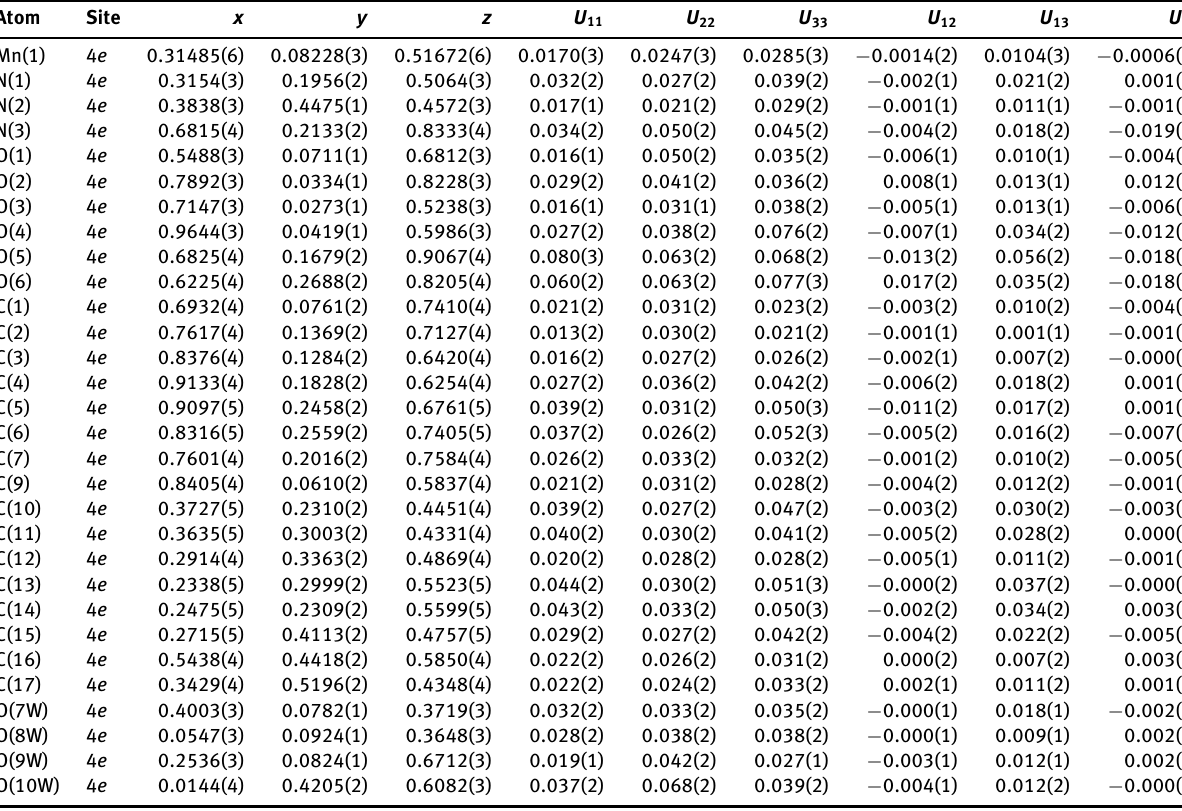
Table 3: Atomic displacement parameters (Å 2